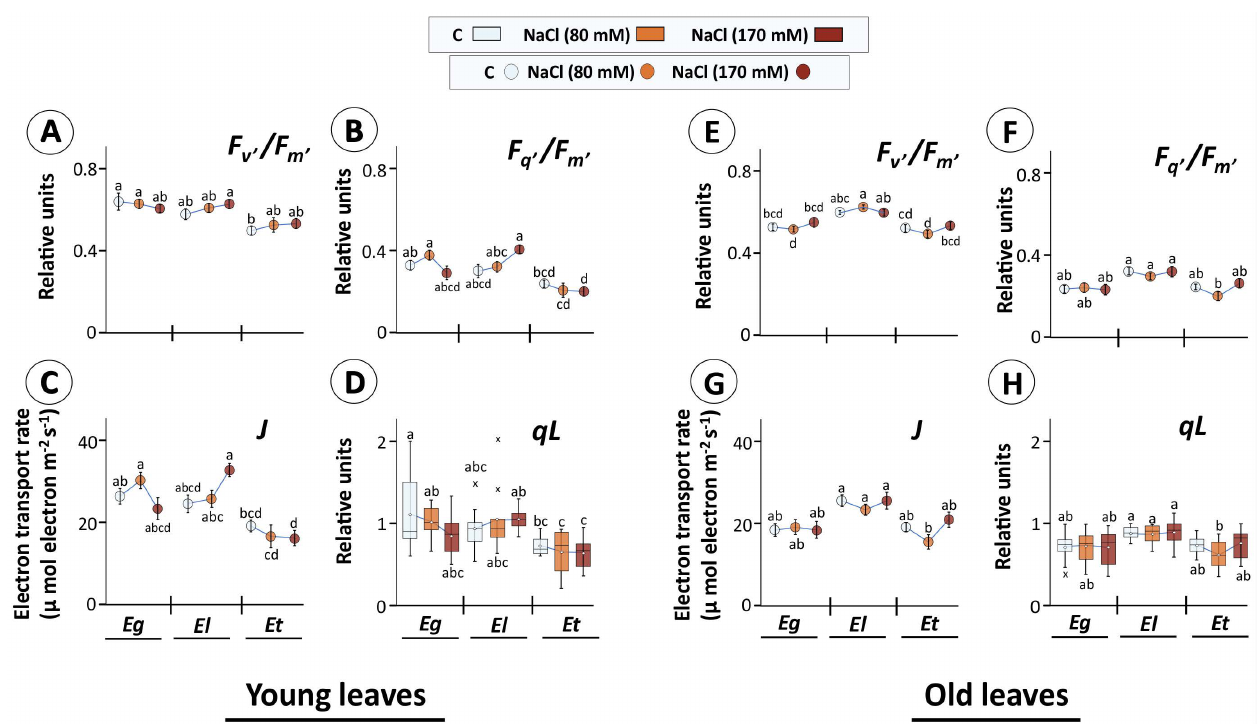
Figure 4. Efficiency of photosystem II (PSII) in selected Eucalyptus species exposed to salinity. Dark-adapted, detached young ( A – D ) and old leaves ( E – H ) of 30 d salt treated Eucalyptus species were exposed to actinic light (160 µ mol m − 2 s − 1 ) for 17s and chlorophyll a fluorescence recorded using the LED array spectrophotometer (DUAL-KLAS-NIR, Walz, Germany). Different parameters like maximum PSII efficiency in light ( F v’ /F m’ ) ( A , E ), operating PSII efficiency in light ( F q’ /F m’ ) ( B , F ), electron transport rate (ETR; J ) ( C , G ), and estimated fraction of open PSII reaction centers ( qL ; data given in form of box plots; ( D , H )) were calculated from chlorophyll a fluorescence data (means ± SE, n = 9–12, p < 0.05; ANOVA and Tukey’s post-hoc test). (In box plots: hollow circle = mean, the horizontal line in the box = median, box limits = 25th, 75th percentiles, whiskers extend 1.5 times the interquartile range from the 25th and 75th percentiles, not connected data points; cross =